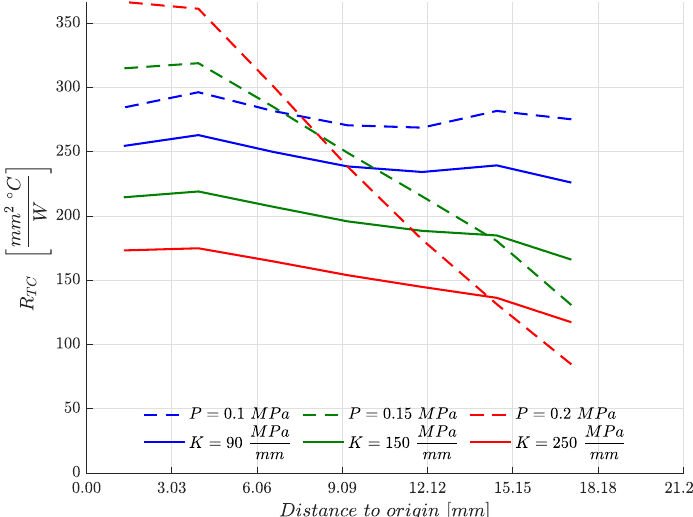
Figure 10. Thermal contact resistance comparison at the nodes located at diagonal of the contact zone for the uniform clamping pressure and Winkler elastic